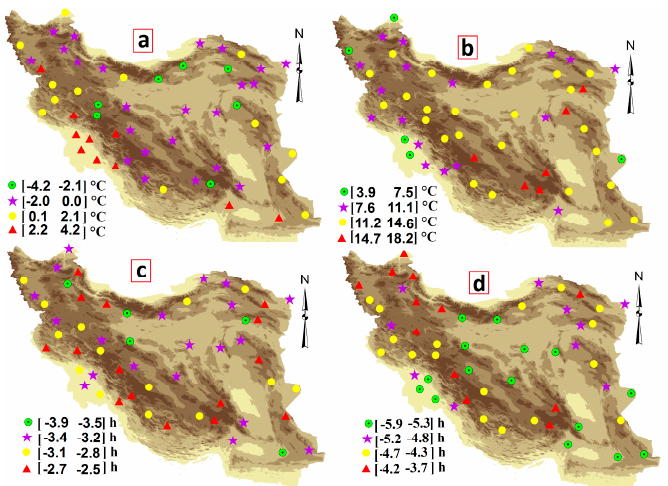
Shahrekurd weather stations.